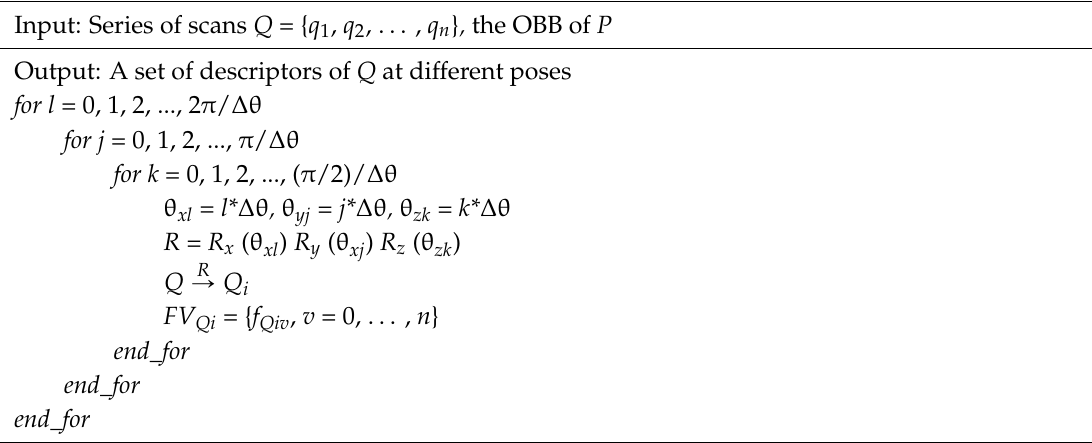
Algorithm 2. Generation of